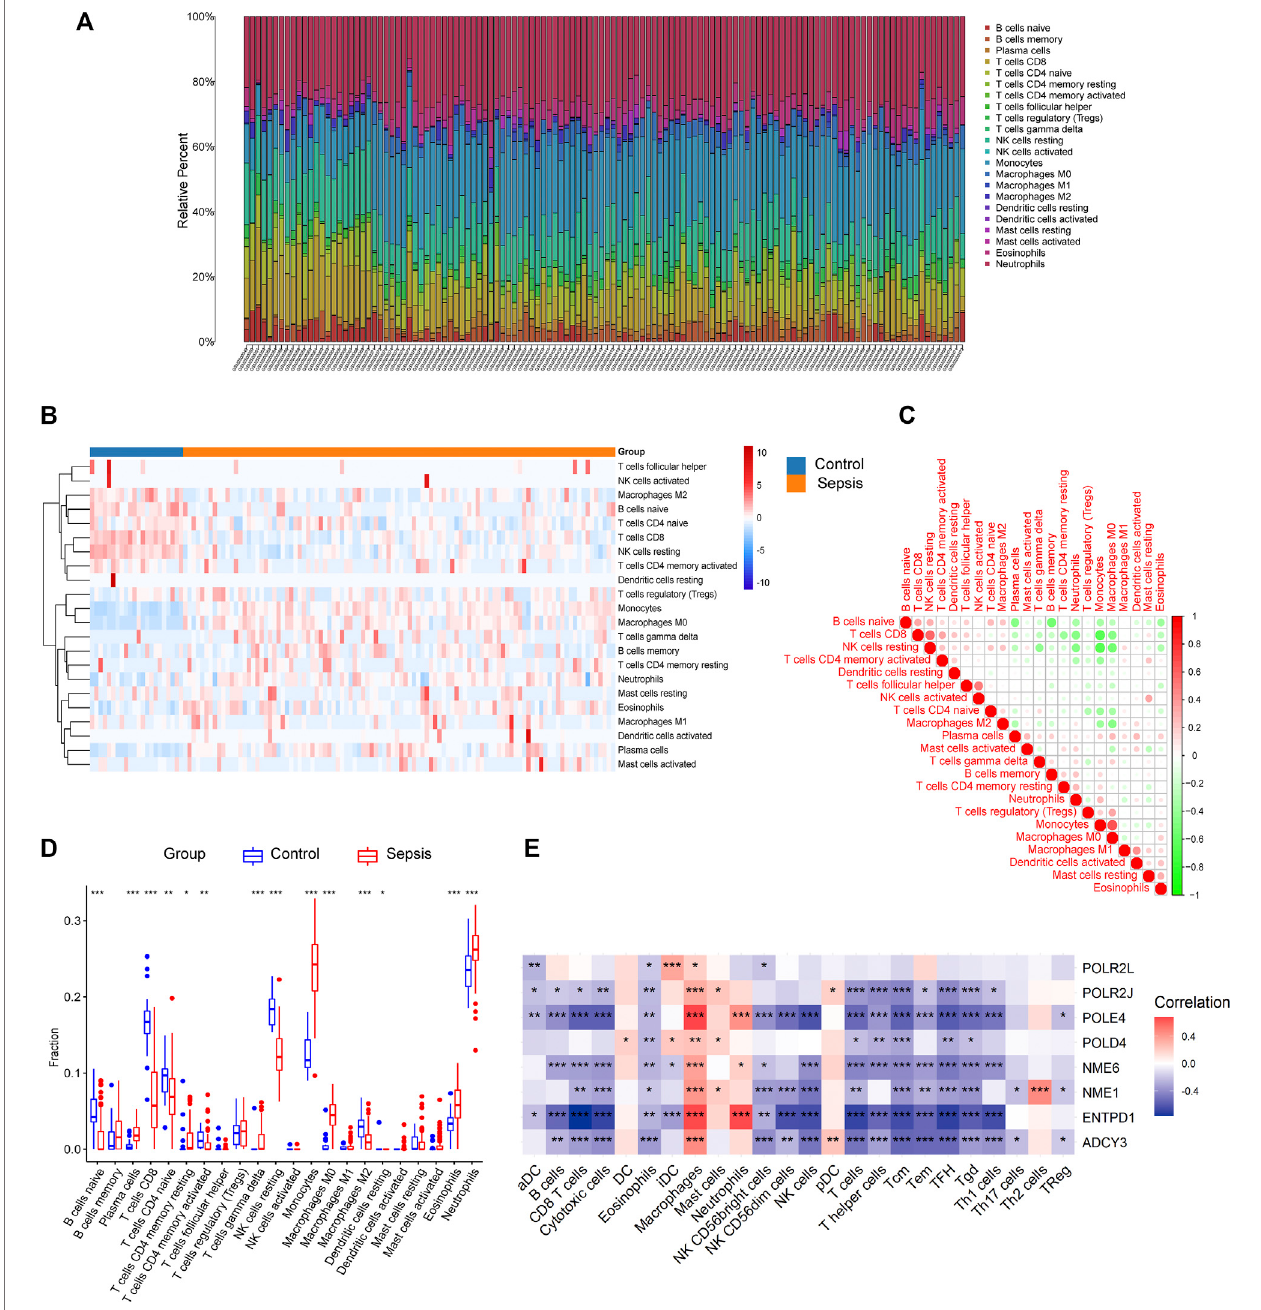
FIGURE 7 | The expressions of the hub genes were correlated with immune cell in fi ltration in GSE95233. (A) Composition and distribution of inferred immune cell in fi ltrationsubsetsineachsample. (B) Heatmapofvisualizingthedifferentiallyin fi ltratedimmunecellsbetweensepsisandhealthycontrol.Thehorizontalbarindicatedthe clustering information of samples that were divided into two major clusters. Vertical bars discriminated between upregulated (red) and downregulated (blue) genes. (C) CorrelationmatrixdisplayingthePearson ’ scorrelationvaluesforeachcomparisonbetweentheimmunecells.Theintensityofthecolorindicatedthestrengthofthe correlationbetweentwoimmunecells.Redindicatespositivecorrelationsandgreenindicatesnegativecorrelations. (D) Boxplotofimmune-cellproportioncomparisons betweensepsispatientsandhealthycontrols(theblueandredboxplotsstandforcontrolandsepsis,respectively). Abbreviation:CIBERSORT:Celltypeidenti fi cationby estimatingrelativesubsets of RNAtranscripts. (E) Pearson ’ s correlation analysis between in fi ltratingimmune cells and identi fi ed hub genes. Red nodes indicate positive correlation while blue nodes indicate negative correlation. * p < 0.05, ** p < 0.01, *** p < 0.001.